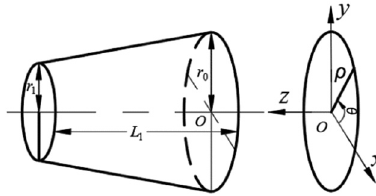
Figure 3: Geometric model of the front - end revolving